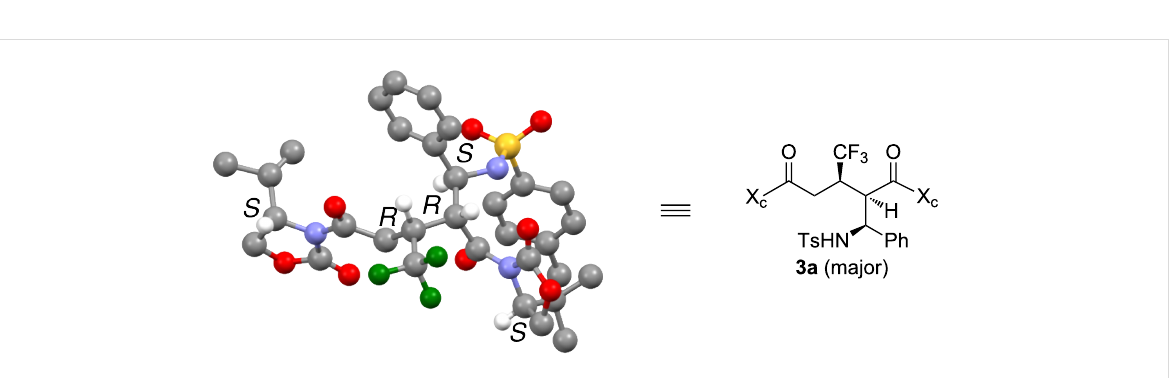
Figure 1: Crystallographic analysis of the major diastereomer of 3a (some hydrogen atoms are omitted for clarity). Each color represents the following atoms: gray, carbon; white, hydrogen; blue, nitrogen; red, oxygen; green, fluorine; yellow, sulfur.